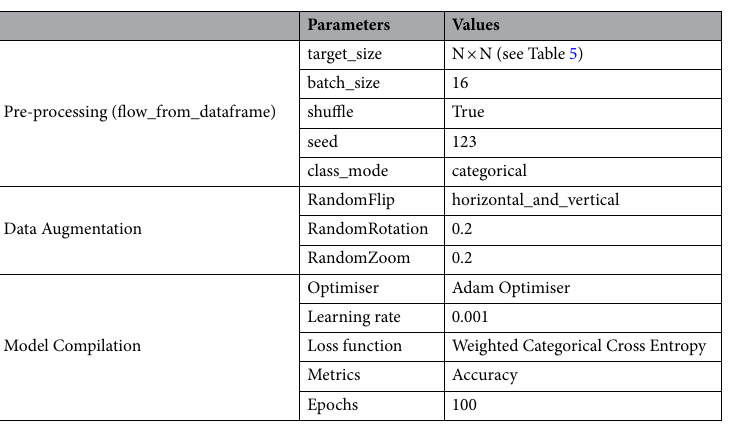
Table 5. This table summarises the seven CNN architectures adopted for the comparative analysis in terms of their main contributions, datasets involved, FLOPs, parameters and input shapes.